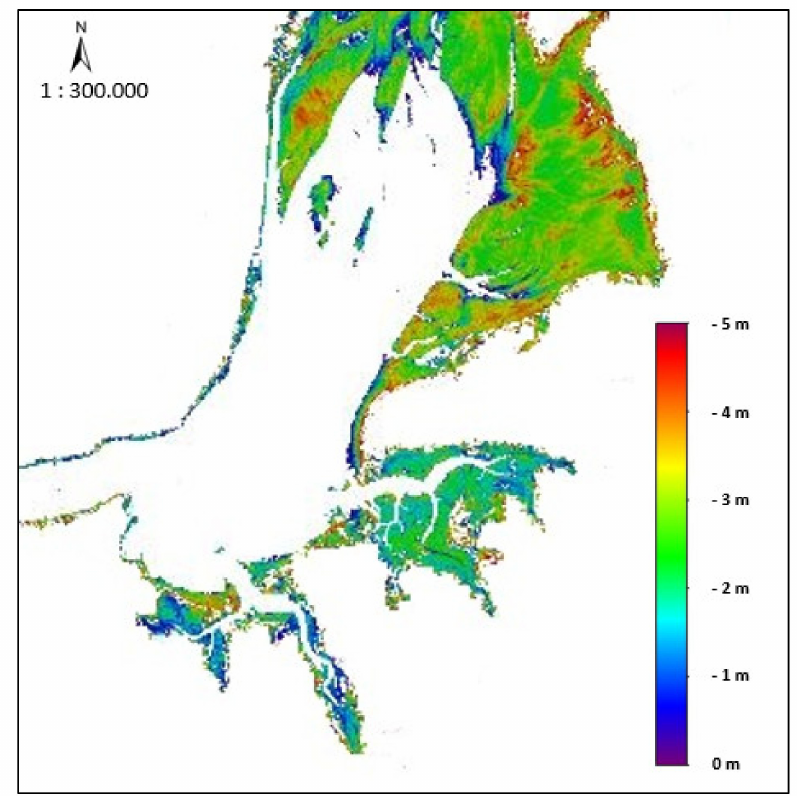
Figure A2. Bathymetric model for the Tagus estuary achieved through the logarithm ratio band algorithm. S2A L2A 08AUG2018